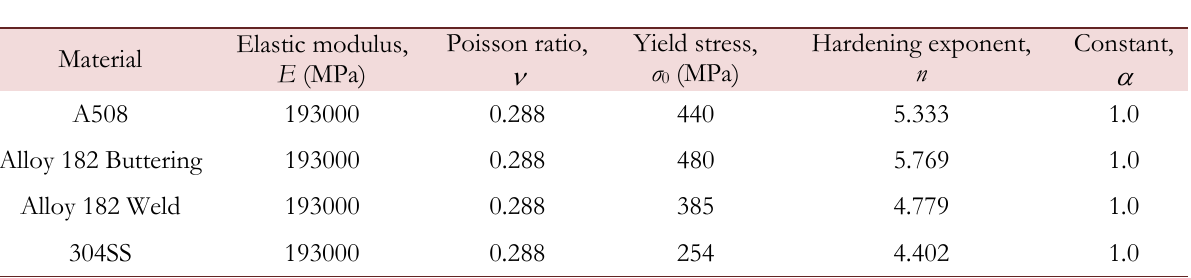
Table 1: Material mechanical parameters for the FEM simulation.